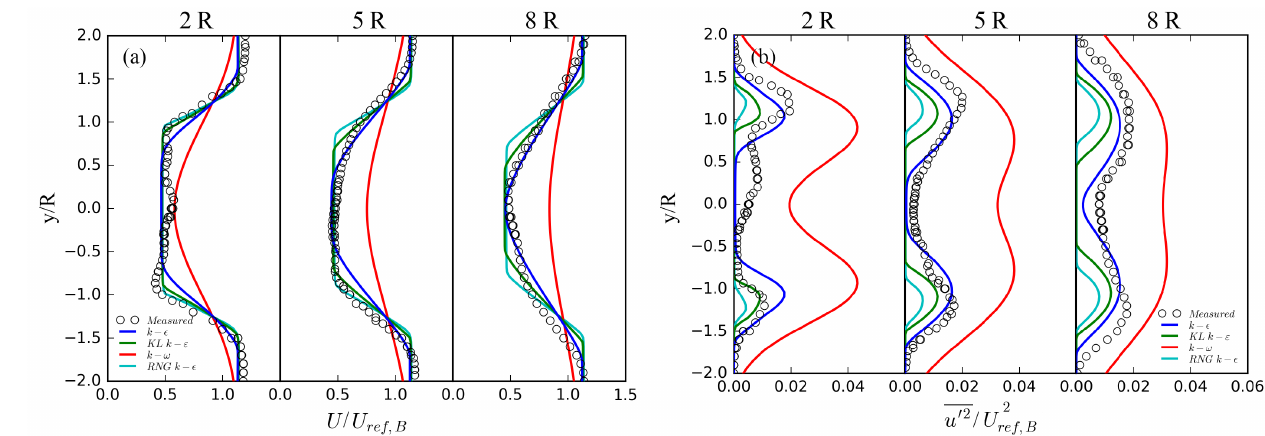
Figure 8. (a) Normalized axial velocity and (b) normalized stream-wise variance of the velocity computed for the two in-line model wind turbines (case B) at x/R = 2, 5 and 8 downstream of the second wind turbine for different turbulence models using the undistributed thrust.